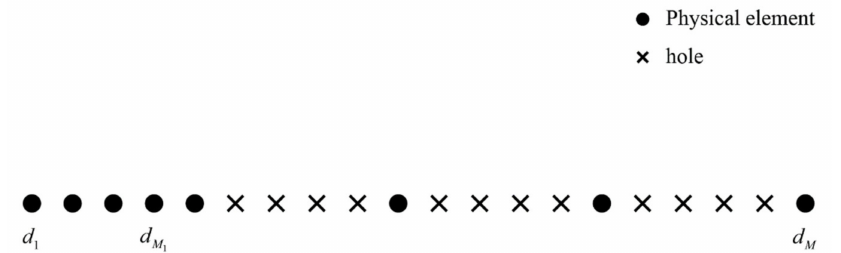
Figure 2. The structure of